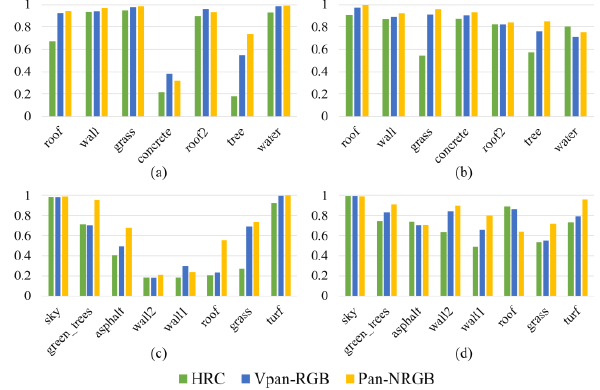
Figure 8: Accuracy assessment of image classification of HRC, Vpan-RGB, and Pan-NRGB images. (a) and (b) UA and PA of Scene 1 images, accordingly. (c) and (d) UA and PA of Scene 2 images, accordingly.